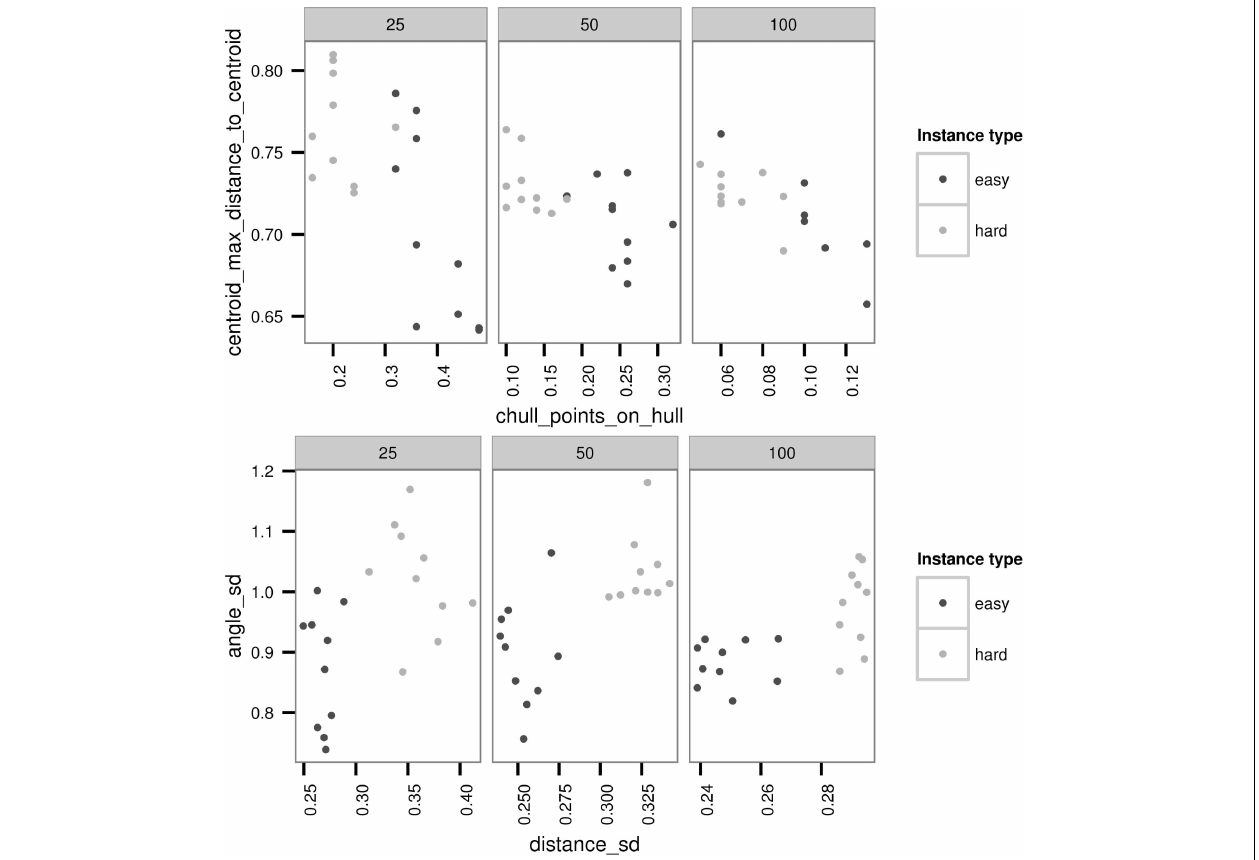
FIGURE 3 | Hard and easy classification with two exemplary feature combinations maximum distance to centroid and the number of points inside the convex hull for parameter setting 2 ( (cid:11) =0, (cid:12) =4) on the top and SD of the angles and distances parameter setting 3 ( (cid:11) =4, (cid:12) =0) on the bottom .